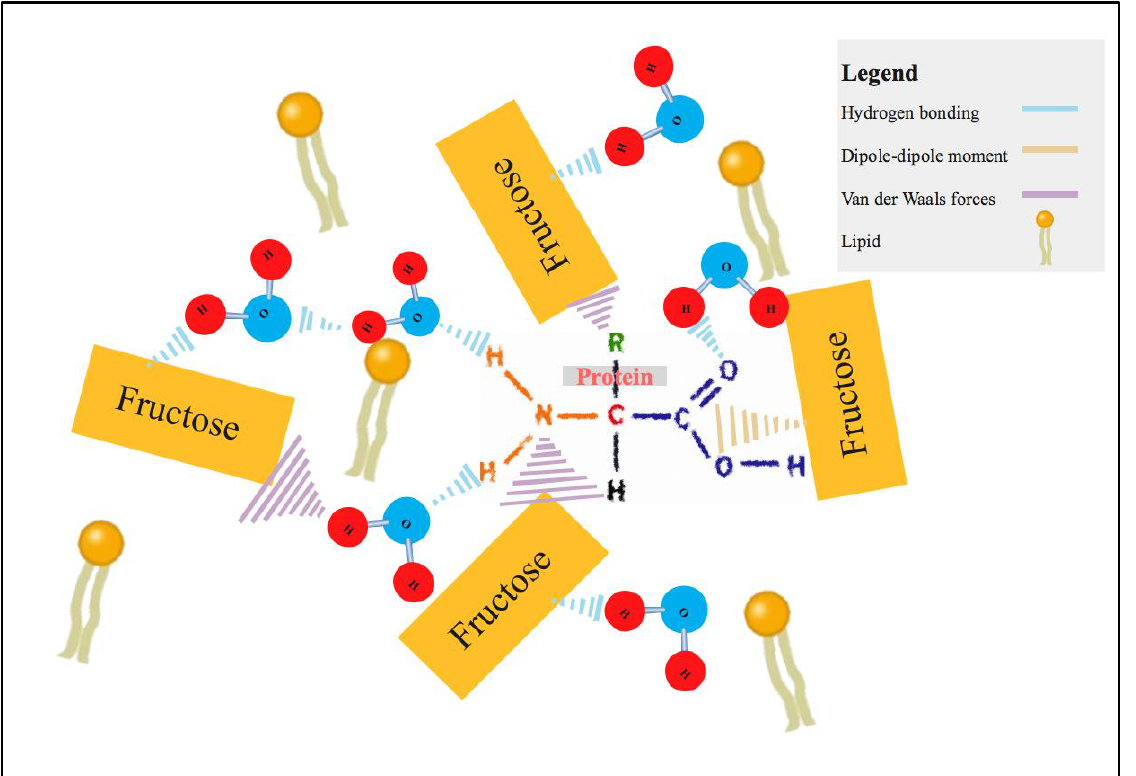
Figure 2. Chemical interaction of protein with fructose and water molecule. The chemical clusters of protein with these molecules allow lipid to move from the bottom phase to the top phase of the LBF system